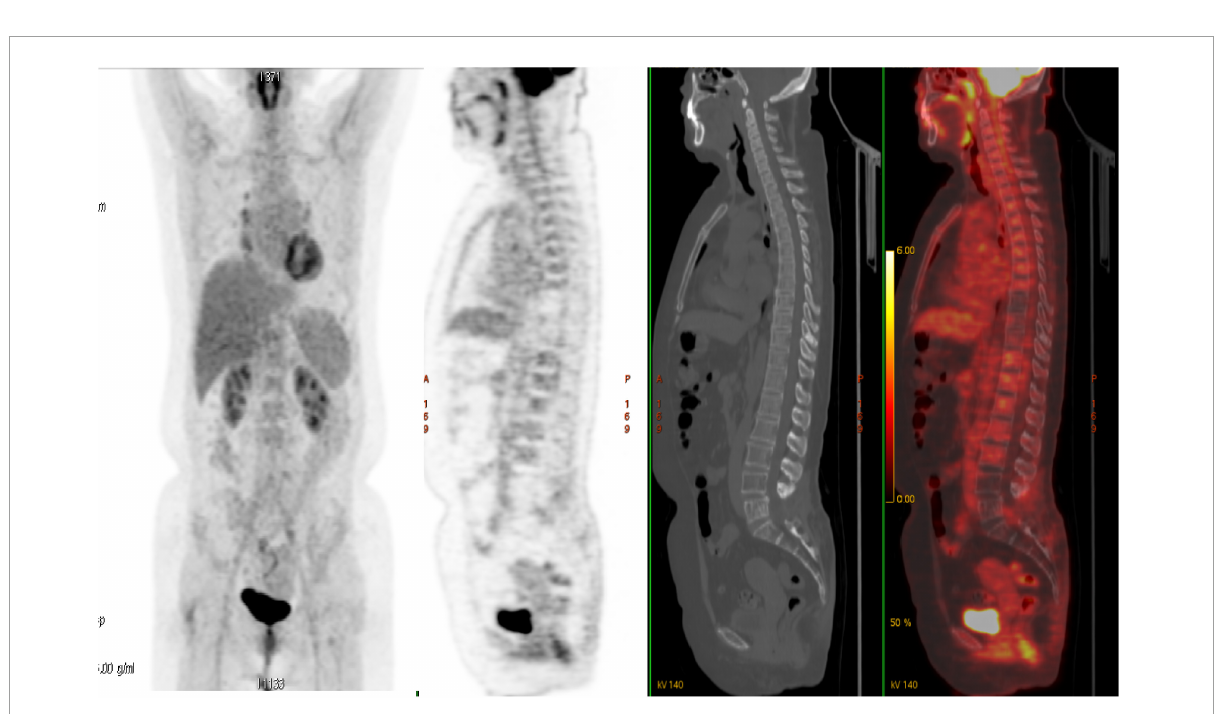
FIGURE2 Follow-up fluorodeoxyglucose positron emission tomography/computed tomography (FDG-PET/CT) after high-dose methotrexate (HD-MTX) showed complete metabolic response with the spine. The patient has maintained complete remission for 10 years after the initial